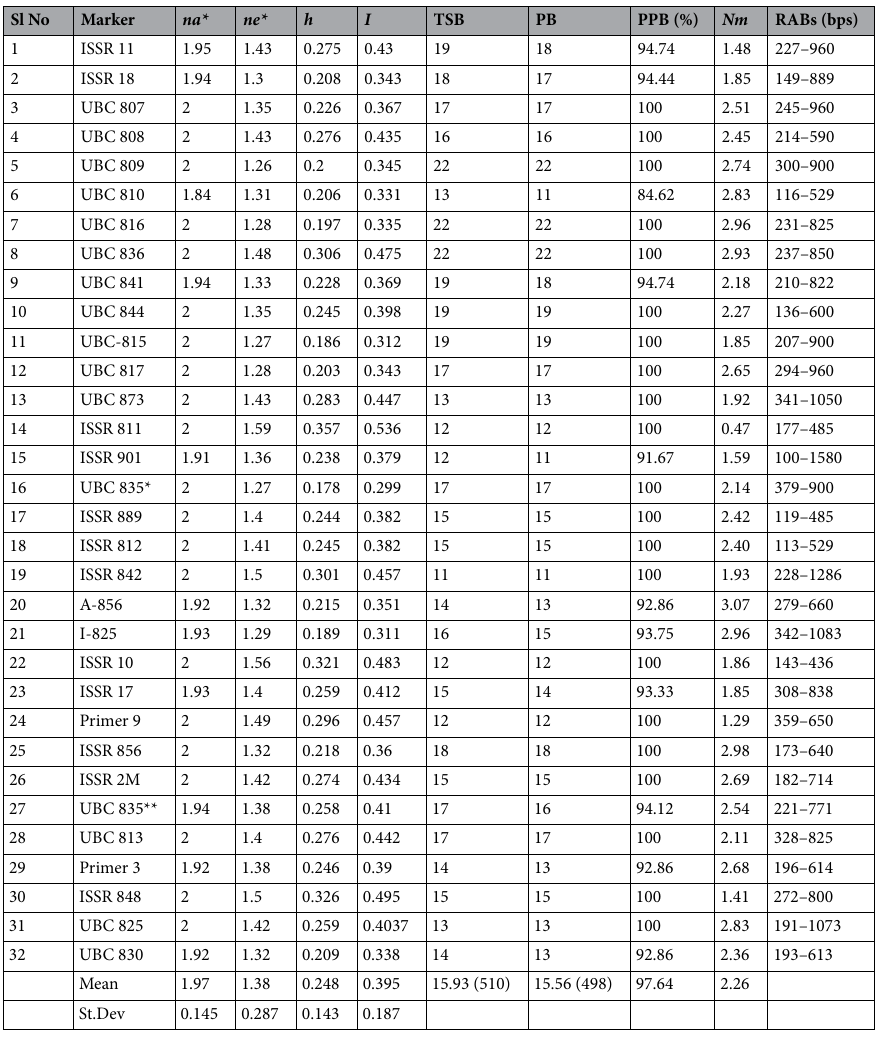
Table 2. The details banding profile and polymorphism revealed by 32 ISSR primers of 44 V . subterranean accessions. * na observed number of alleles, * ne effective number of alleles, * h Nei’s gene diversity, * I Shannon’s information index; Nm estimation of geneflow; range of amplified bands (RABs), TSB total scored band, TSB total scored band, PPB percent polymorphic band. * and **Both (UBC 835) name are same as per the source of the collection, but the sequences are not same and collected from two different